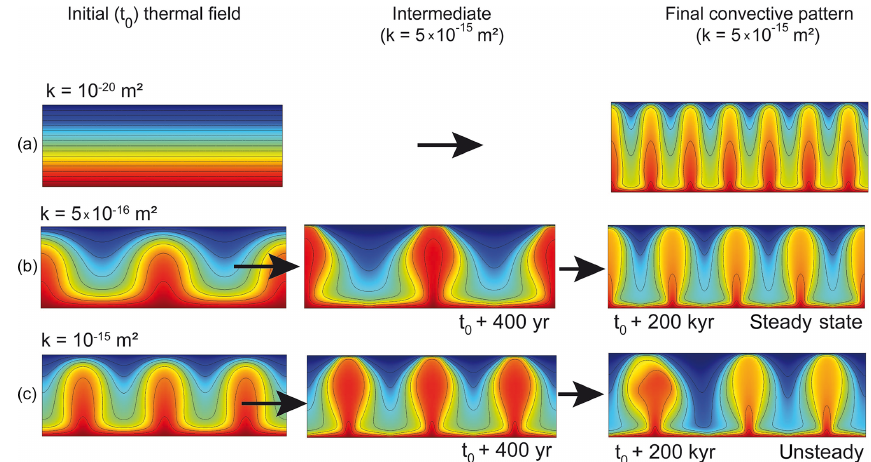
Figure 5. Illustration of thermal inheritance. For the three cases, the final permeability is the same but the initial thermal regime differs. In the first case (a) , the initial thermal regime is purely conductive (top left). A finger-like morphology is obtained for the upwellings. In the two other cases (b, c) , the convective pattern appears to be controlled or influenced by the initial one. A bulb-like morphology is promoted for the upwellings. The color bar (not shown) is the same as in previous figures.